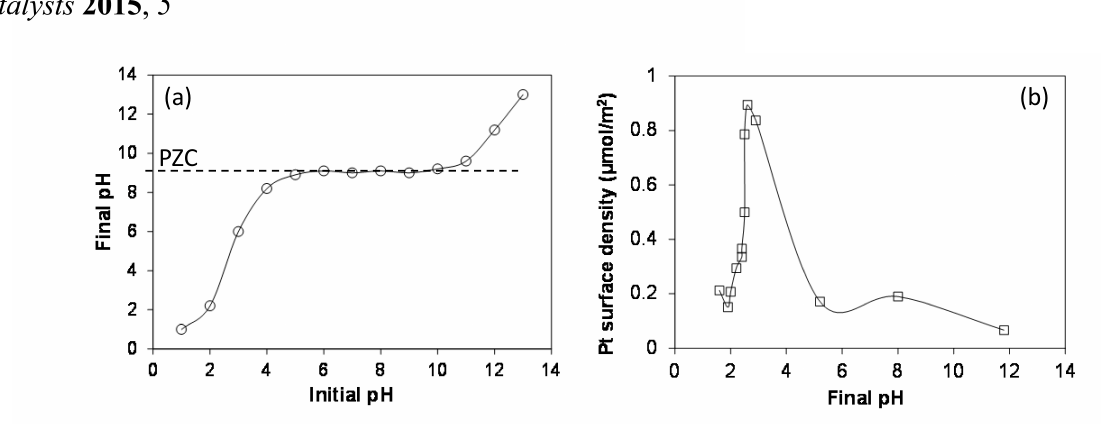
Figure 2. ( a ) pH equilibrium (point of zero charge (PZC) measurement) for the